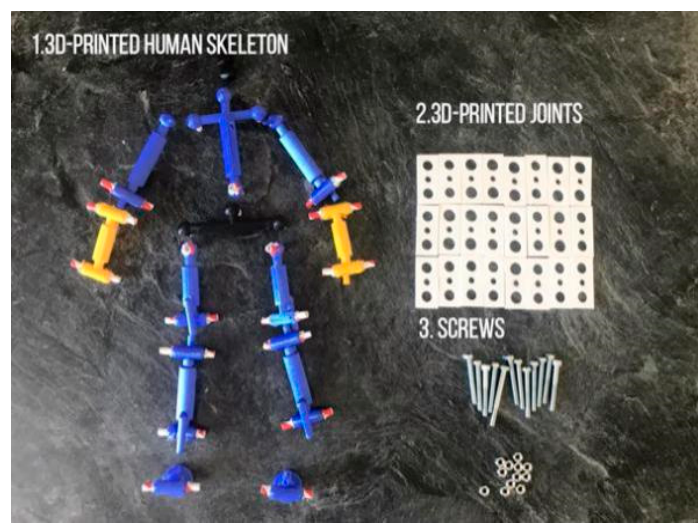
Figure 2. The moving mode and range of each joint in the model.